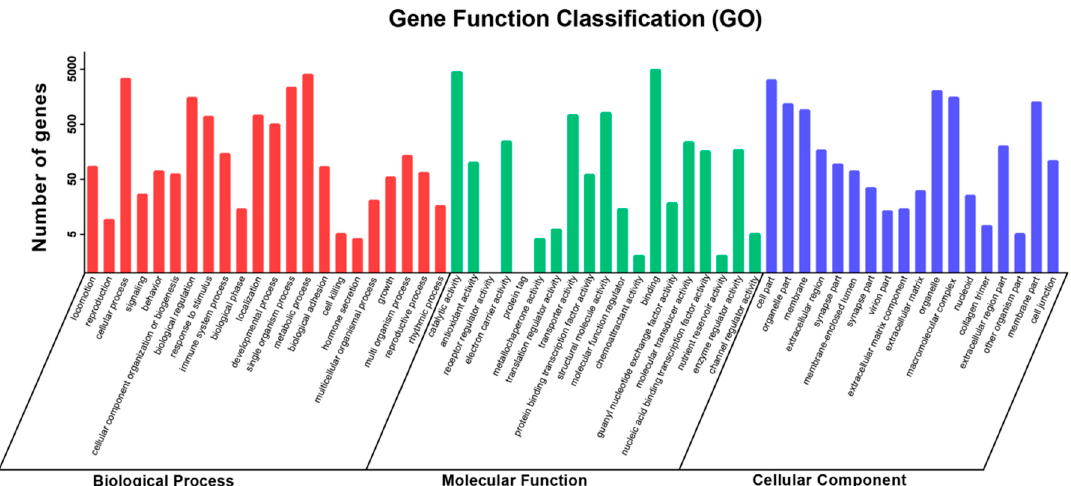
Figure 1. Gene Ontology (GO) classifications of unigenes. The y -axis represents the number of the unigenes, the x -axis shows three categories and their subcategories.